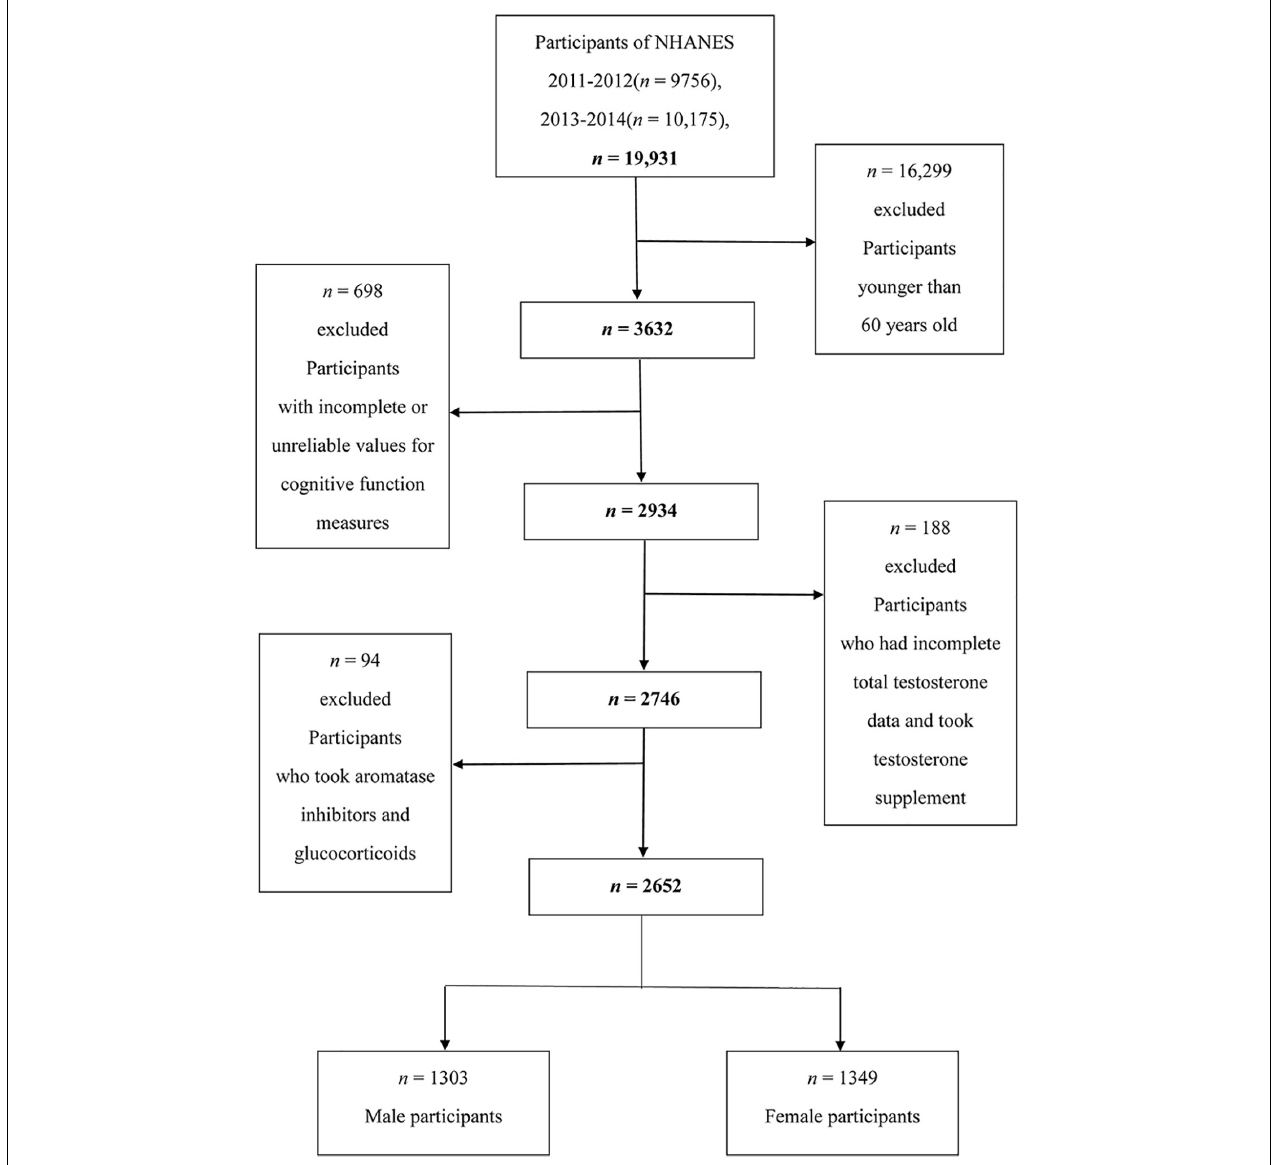
FIGURE 1 | Flow chart of the screening process for the selection of eligible